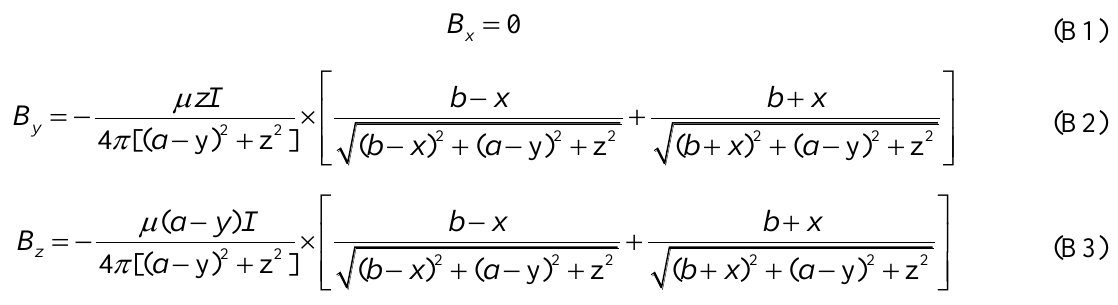
Figure B2. Coordination of single wire in three-dimensional